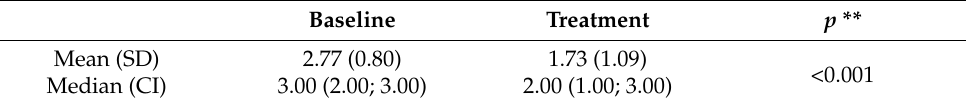
Table 2. Comparison of denture-related stomatitis score at the baseline and after treatment with the hygiene protocol; (95% CI).